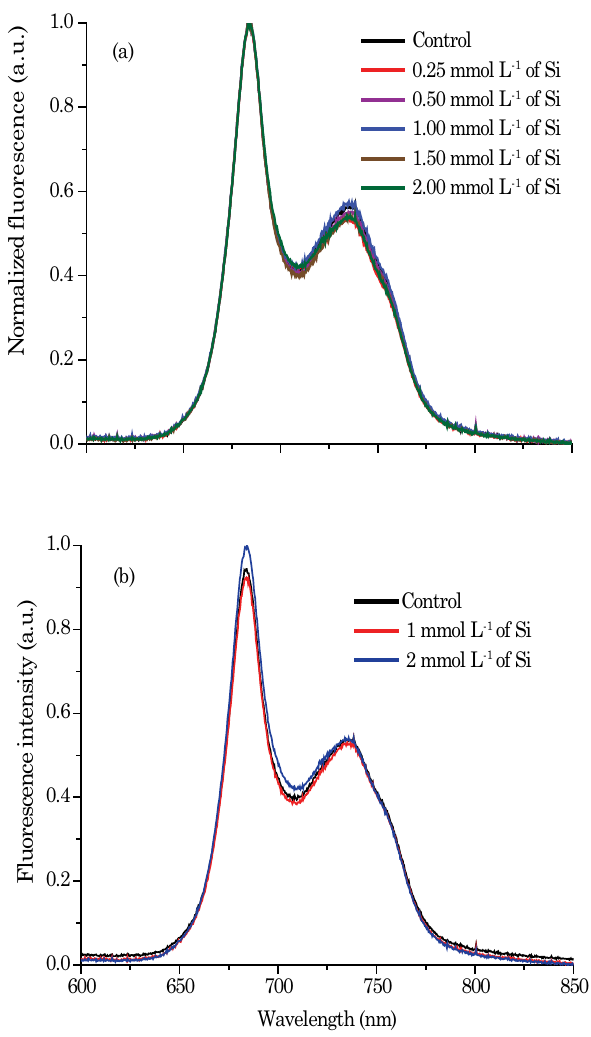
Figure 2. (a) Spectra of chlorophyll fluorescence in maize plants grown under different Si application rates in a nutrient solution contaminated by arsenic. (b) Maximum intensity of chlorophyll fluorescence for the highest silicon application rates in the nutrient solution.